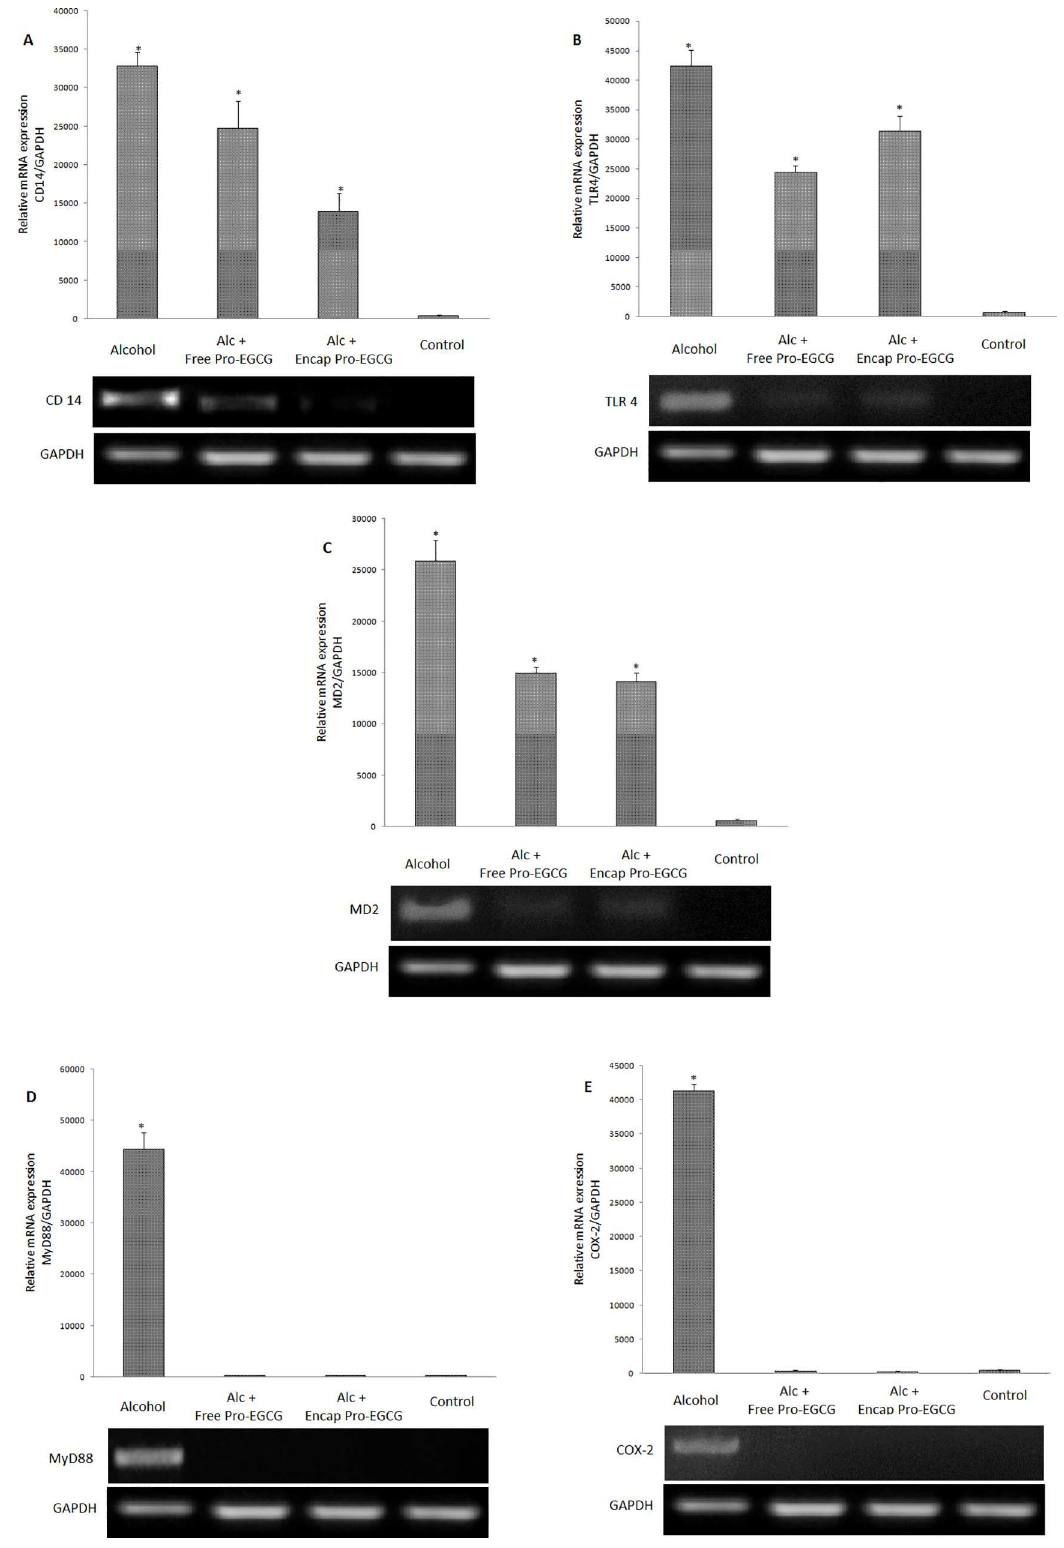
Fig 8. RT-PCR analysis of liver TLR4, CD14, MD2, MyD88 COX-2 mRNA expressions. Alc- alcoholgroup; Alc+ FPE- Alcohol+free probiotic-EGCG group, Alc + EPE- Alcohol+co-encapsulated probiotic-EGCG group. * p < 0.05vs.